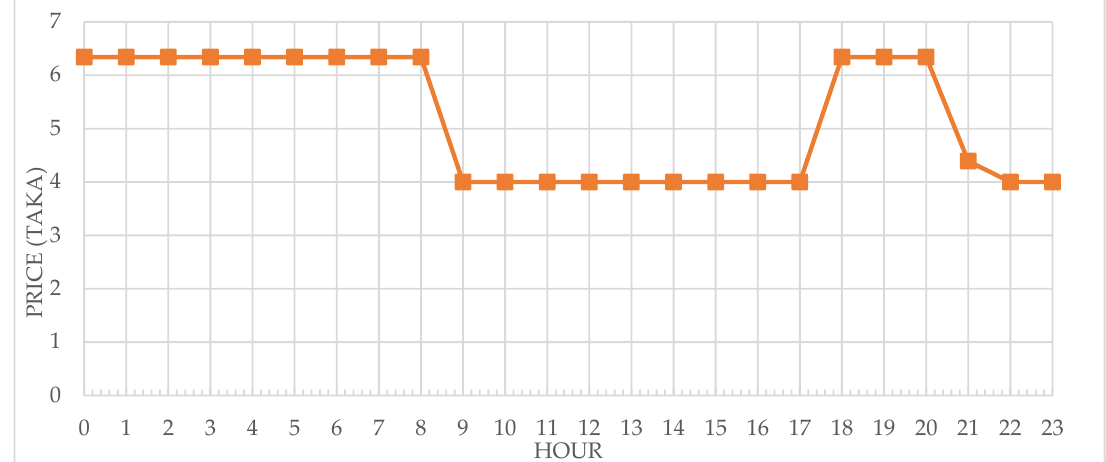
Figure 9. Hourly internal buying price of the consumer.